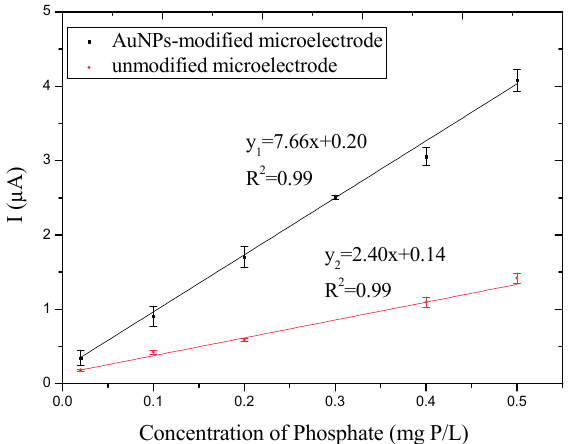
Figure 6. Calibration curve of phosphate standard solution